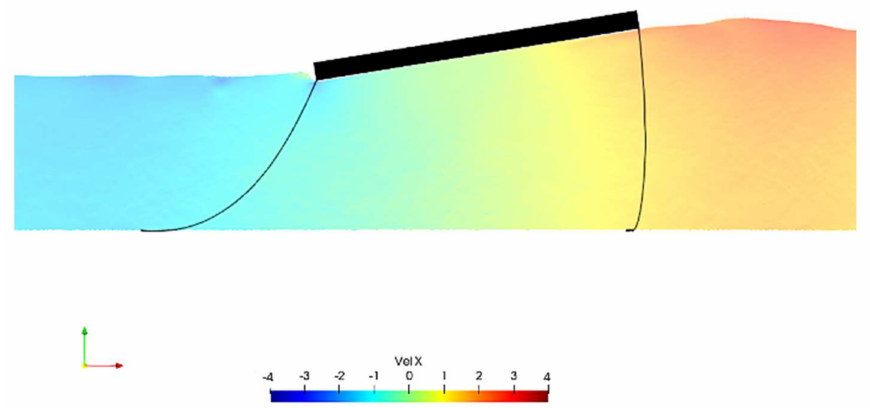
Figure 15. Snapshot of the mariculture platform with H = 3.7 m, T = 9.9 s, and d = 11.88 m simulated with SPH. Particle colors correspond to the horizontal flow velocity.